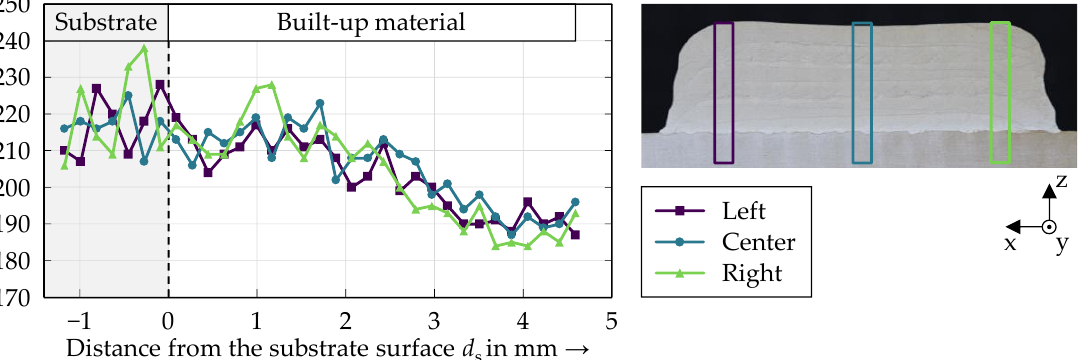
Figure 13. Microhardness distribution of the built-up cuboid along the z-direction at the center and the lateral regions.